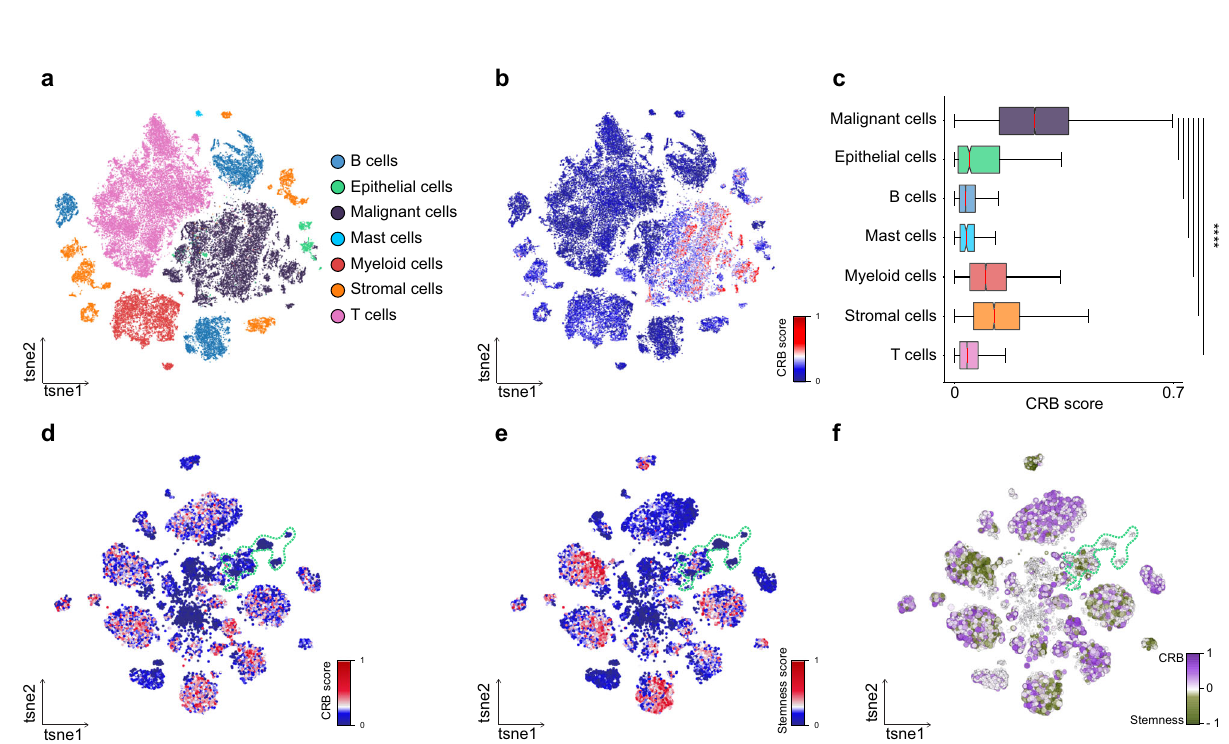
Fig. 5 Conserved human CRC enhancer regions are accessible across diverse cancer types. a Chromatin accessibility pro fi les of the 195 conserved gained enhancers in 23 diverse primary human cancer types reveal a signature of 46 pan-CRC enhancers with active chromatin pro fi les across cancer types (cluster in purple). The heatmap shows hierarchical clustering of log2 normalized insertion counts of ATAC-seq data derived from TCGA (Corces et al. 17 ). Colon adenocarcinoma samples are the fi rst cancer type reported on the left of the heatmap. The color-coded bar above the heatmap represents the different cancer types: ACC adrenocortical carcinoma, BLCA bladder urothelial carcinoma, BRCA breast invasive carcinoma, CESC cervical squamous cell carcinoma, and endocervical adenocarcinoma, CHOL cholangiocarcinoma, COAD colon adenocarcinoma, ESCA esophageal carcinoma, GBM glioblastoma multiforme, HNSC head and neck squamous cell carcinoma, KIRC kidney renal clear cell carcinoma, KIRP kidney renal papillary cell carcinoma, LGG brain lower grade glioma, LIHC liver hepatocellular carcinoma, LUAD lung adenocarcinoma, LUSC lung squamous cell carcinoma, MESO mesothelioma, PCPG pheochromocytoma and paraganglioma, PRAD prostate adenocarcinoma, SKCM skin cutaneous melanoma, STAD stomach adenocarcinoma, TGCT testicular germ cell tumors, THCA thyroid carcinoma, UCEC uterine corpus endometrial carcinoma. b Differences in the H3K27ac intensities of the pan-cancer enhancers in primary tumors ( n = 28) relative to normal tissues ( n = 15) from public ChIP-seq data. Boxplots describe the median (middle line) and interquartile range (box denoting fi rst and third percentile) with whiskers denoting the minimum and maximum within the 1.5× interquartile range and outlying points beyond the whiskers plotted individually. **** P < 0.0001, two-sided Wilcoxon rank sum exact test. c Genomi c overview of the TAZ locus in representative normal tissue and patient-derived organoid (PDO) samples, and in TCGA cancer types. Upper panel: H3K27ac pro fi les, ChromHMM states and RNA-seq signals in normal tissue; H3K27ac and TAZ pro fi les, ChromHMM states, and RNA-seq signals in PDO; and CRC capture Hi-C data. Bottom panel: ATAC-seq pro fi les for 23 TCGA cancer types. The shaded box indicates a CRC-conserved and YAP/TAZ-bound ChromHMM-de fi ned active enhancer for which a promoter-enhancer interaction is reported using CRC capture Hi-C data. See Fig. 2c, e for details on ChromHMM tracks.